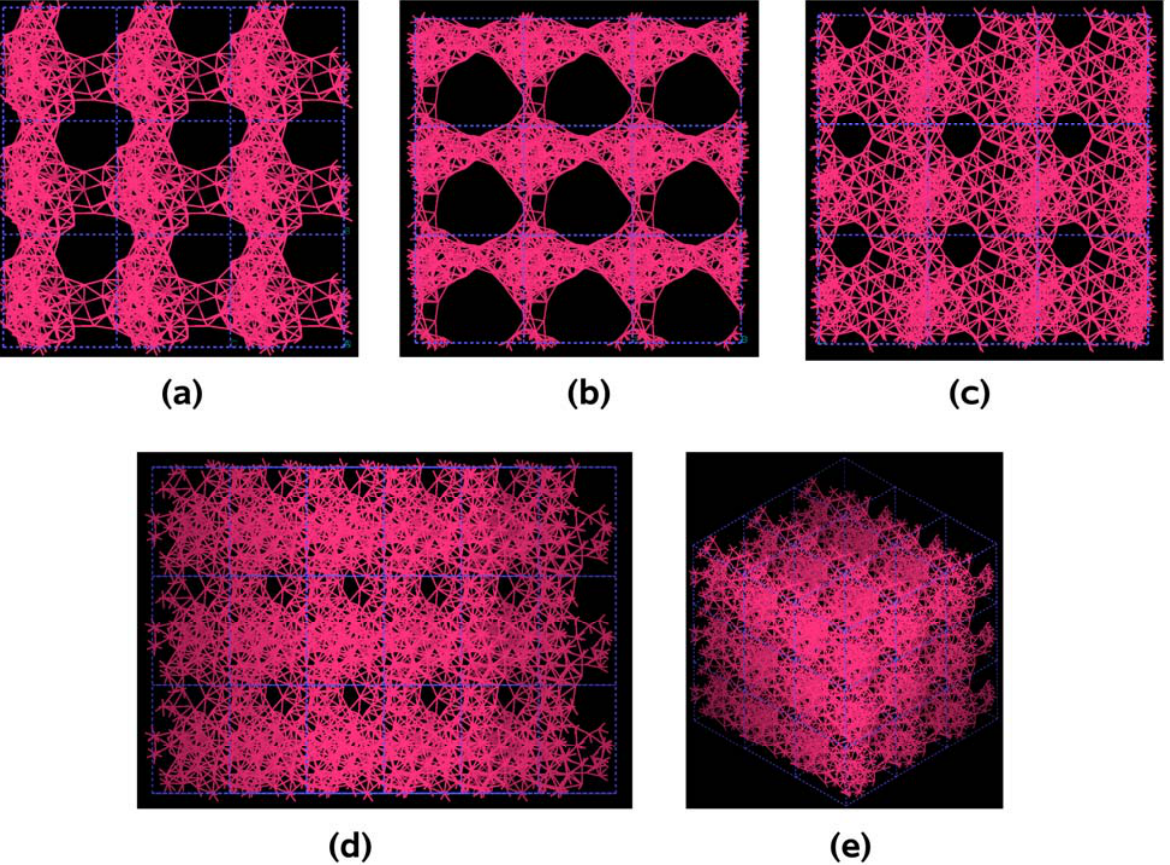
Figure 22. Pores formed in a 3 × 3 × 3 50% porosity aluminum supercell when it undergoes an MD process at 300 K during 500 steps. There are prominent through pores along (a) x, and (b) y directions, and smaller pores along (c) z, (d) xz and (e) xyz